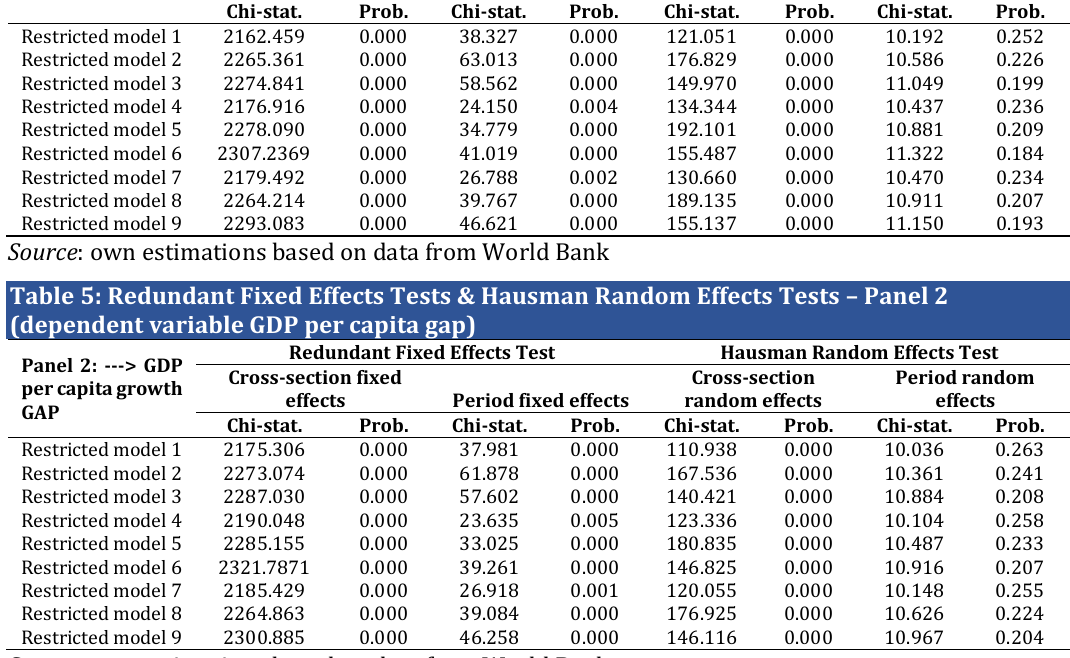
restricted models, both panels by introducing the cross-section random effects and period fixed effects restrictions. Table 4: Redundant Fixed Effects Tests & Hausman Random Effects Tests – Panel 1 (dependent variable GDP gap) Panel 1: ---> GDP Growth GAP